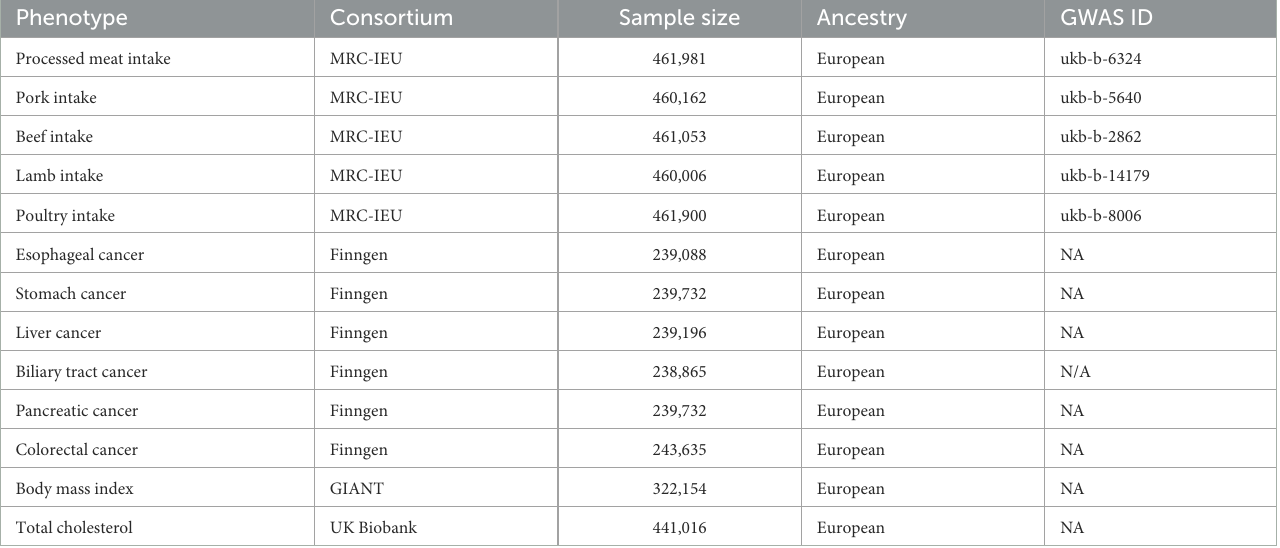
TABLE 1 Details of all GWAS data in this